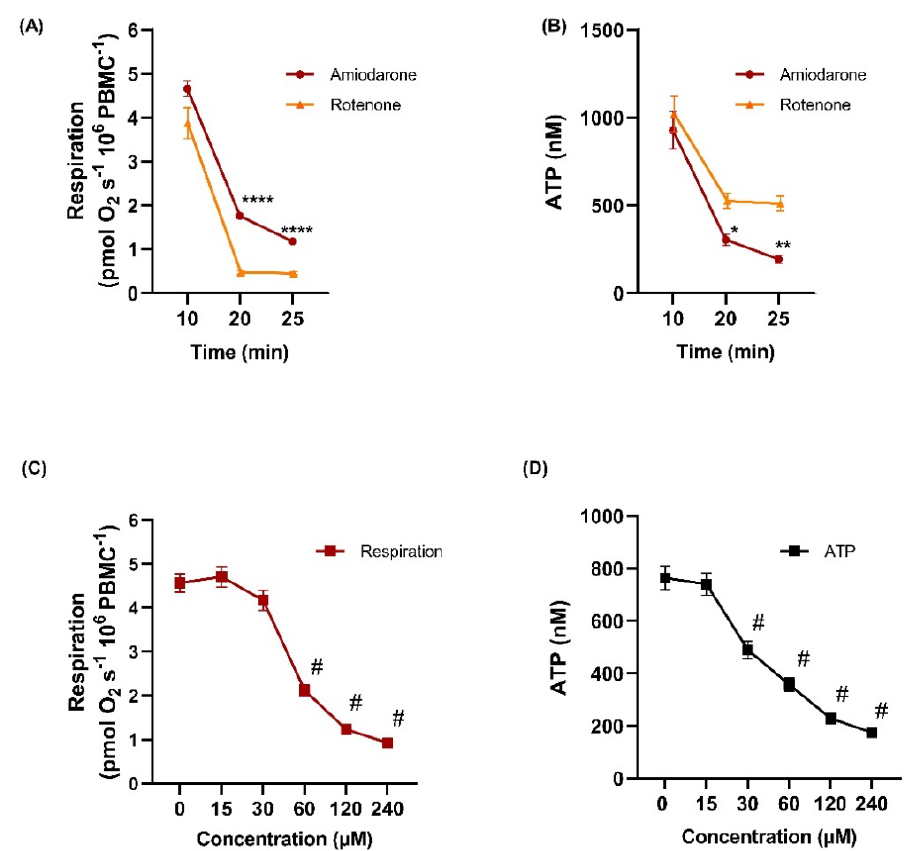
Figure 4. Delayed toxicity and ATP-depletion by amiodarone in mononuclear cells. Temporal decline of respiration ( A ) and ATP levels ( B ) was observed in intact PBMCs following single administration of amiodarone (100 µ M, red) and rotenone (2 µ M, orange), added on routine (basal) respiration. ( C ) Oxygen consumption (red square) and ( D ) ATP concentration (black square) followed amiodarone titration. Amiodarone was added at 10, 15, 20, 25 and 30 min at the final concentrations of 15, 30, 60, 120 and 240 µ M. Data were expressed as mean ± SEM. Two-way ANOVA with Bonferroni post